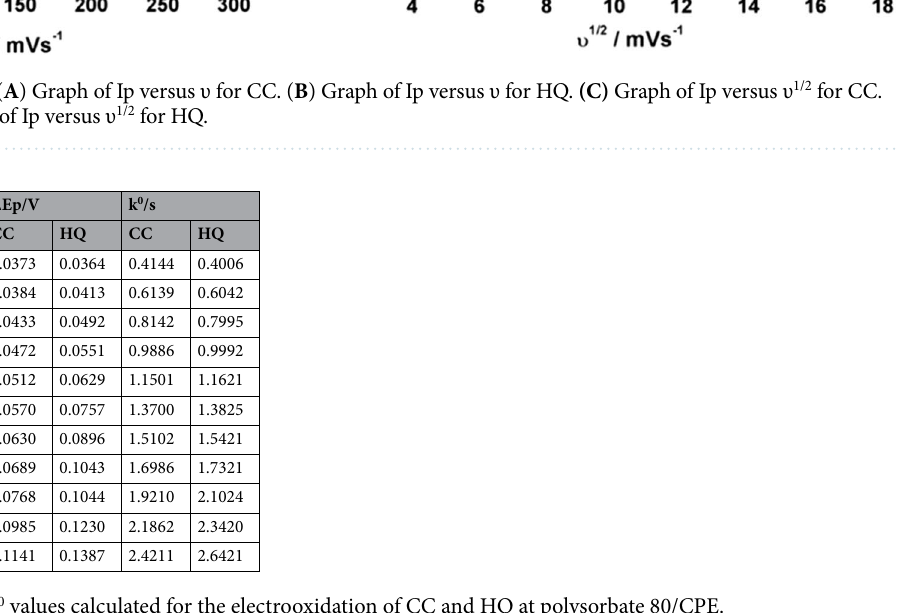
Table 3. k 0 values calculated for the electrooxidation of CC and HQ at polysorbate